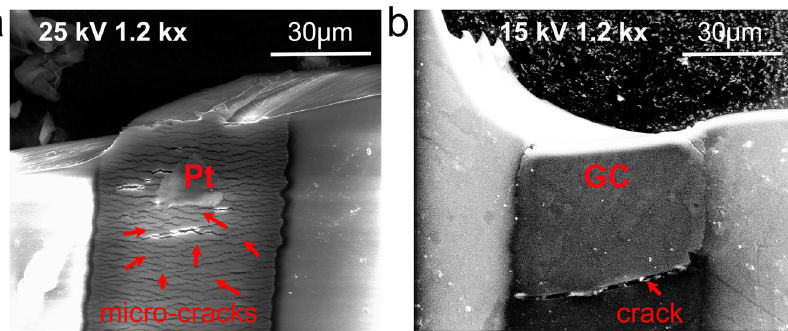
Figure 3. Details of fracture planes following mechanical testing of aGC and thin-film metal (Pt) probes. ( a ) SEM image highlighting failure plane in probes with metal interconnects where numerous micro-cracks were developed prior to and at time of failure. ( b ) SEM image of failure plane in aGC probes. Apart from the failure plane, a single crack is observed at failure while the rest of GC interconnects remain intact. This micro-crack extends through the width of the specimen consistent with cracks that form during failure of homogeneous